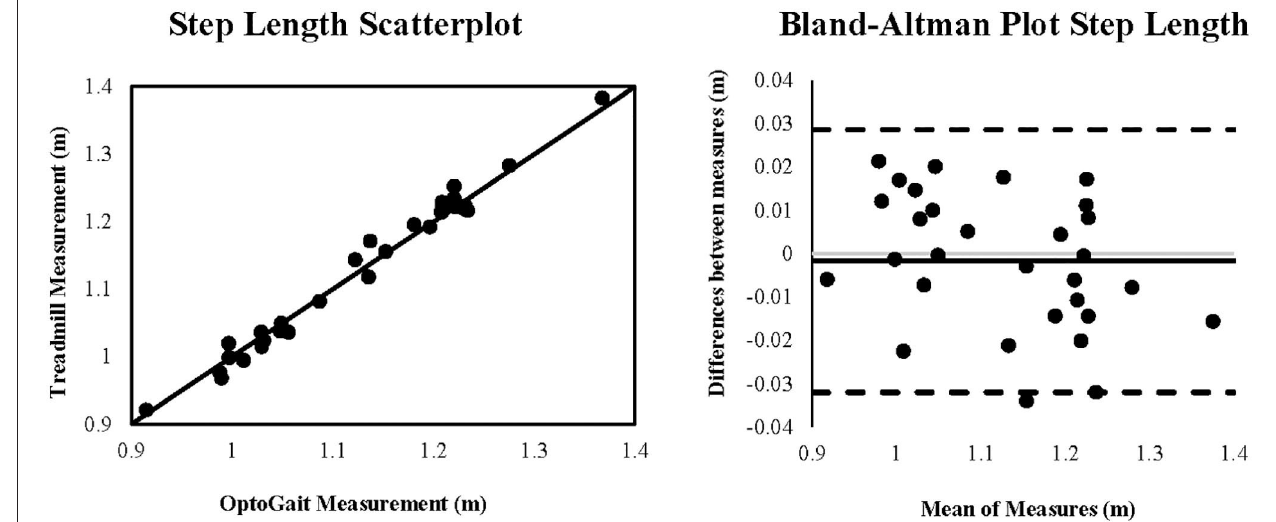
FIGURE 2 | Scatterplot and Bland-Altman plot for the measurement of step length (meters) during running for the OptoGait vs. instrumented treadmill. The Bland-Altman plot includes the bias (solid black line) and the upper and lower 95% limits of agreement (dashed lines).